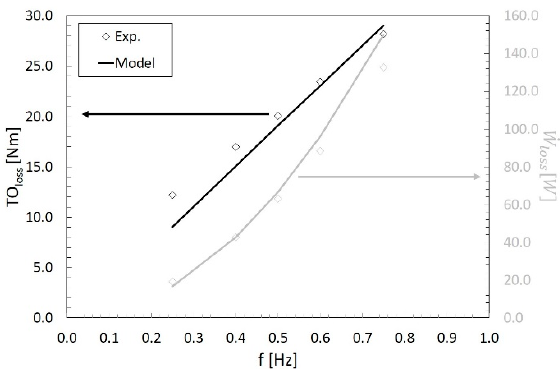
Figure 9. Comparison between experimental (symbols) and simulation (full line) results of resistant torque (black symbols and full line on the left y -axis, only losses contribution) and mechanical power losses (grey symbols and full line on the right y -axis).